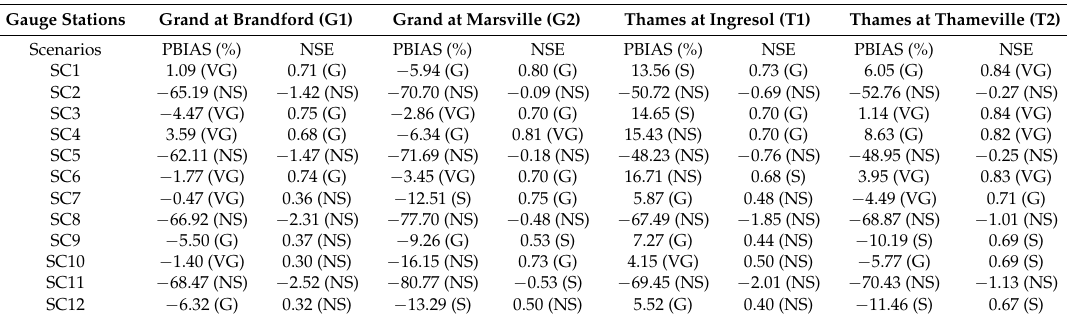
Table 3. Model performance statistics.